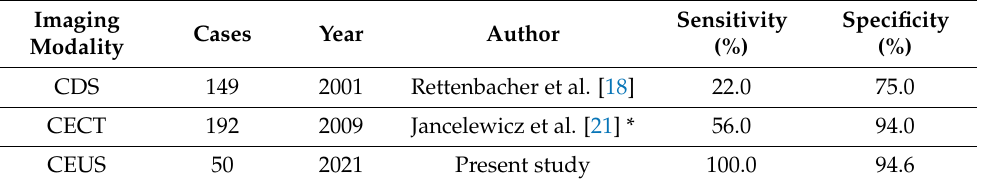
Table 4. Diagnostic performance of color Doppler sonography, contrast-enhanced ultrasound, and contrast-enhanced computed tomography for evaluating perfusion